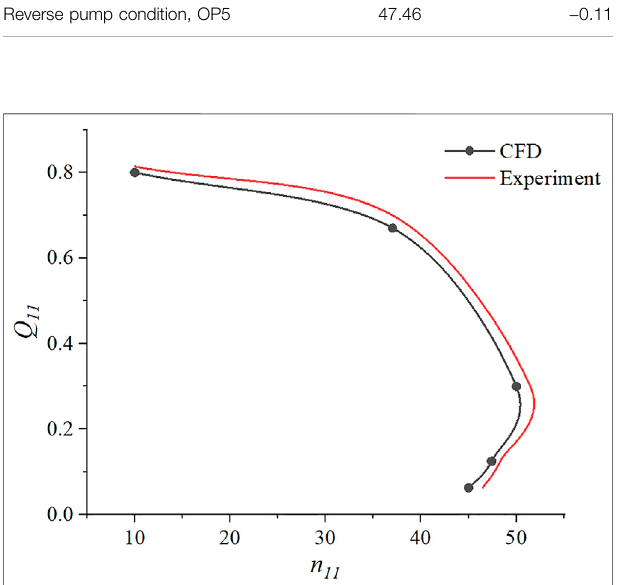
FIGURE 4 | Turbine operating characteristic curves.